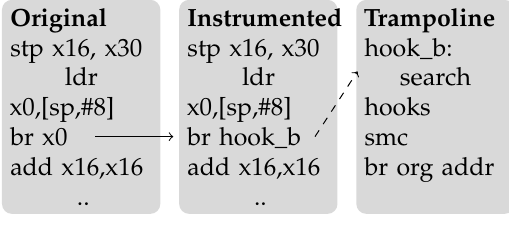
Figure 3. C − FLAT Instrumented.